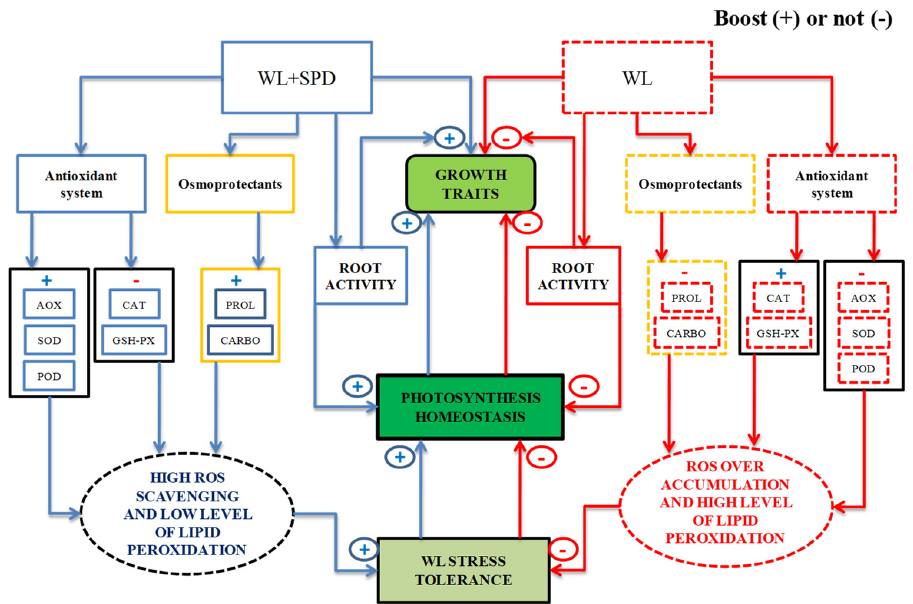
Figure 9. A model design showing how SPD influenced the physio-biochemical systems in C. oleifera seedlings under WL.